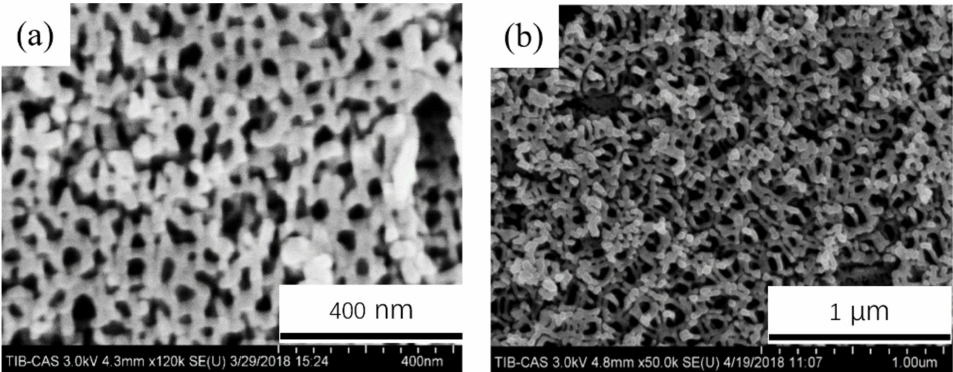
Figure 9. SEM images of 2024 anodic oxide films at different electrolyte concentrations: ( a ) 4 wt%; ( b ) 10